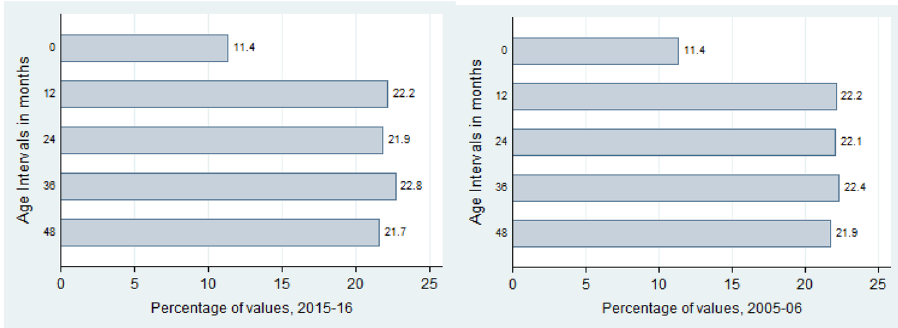
Figure 2. Age distribution in completed